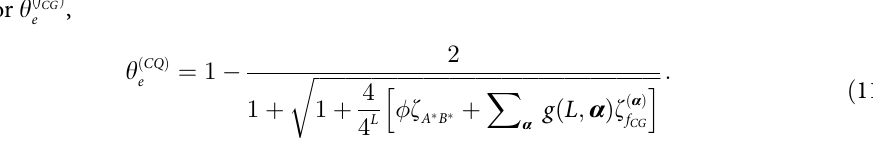
. Conditions are NaCl